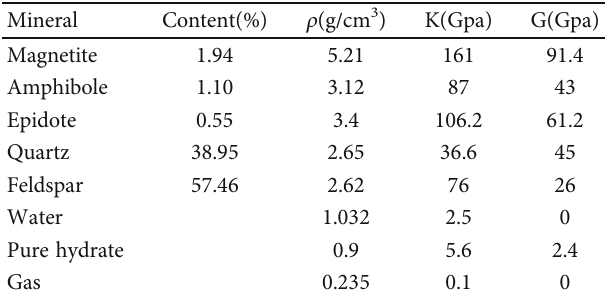
Figure 8: Variation of measured and model-calculated V Supplementary Table 3: Mineral composition and physical parameters of the experimental sediments [34 – 36].